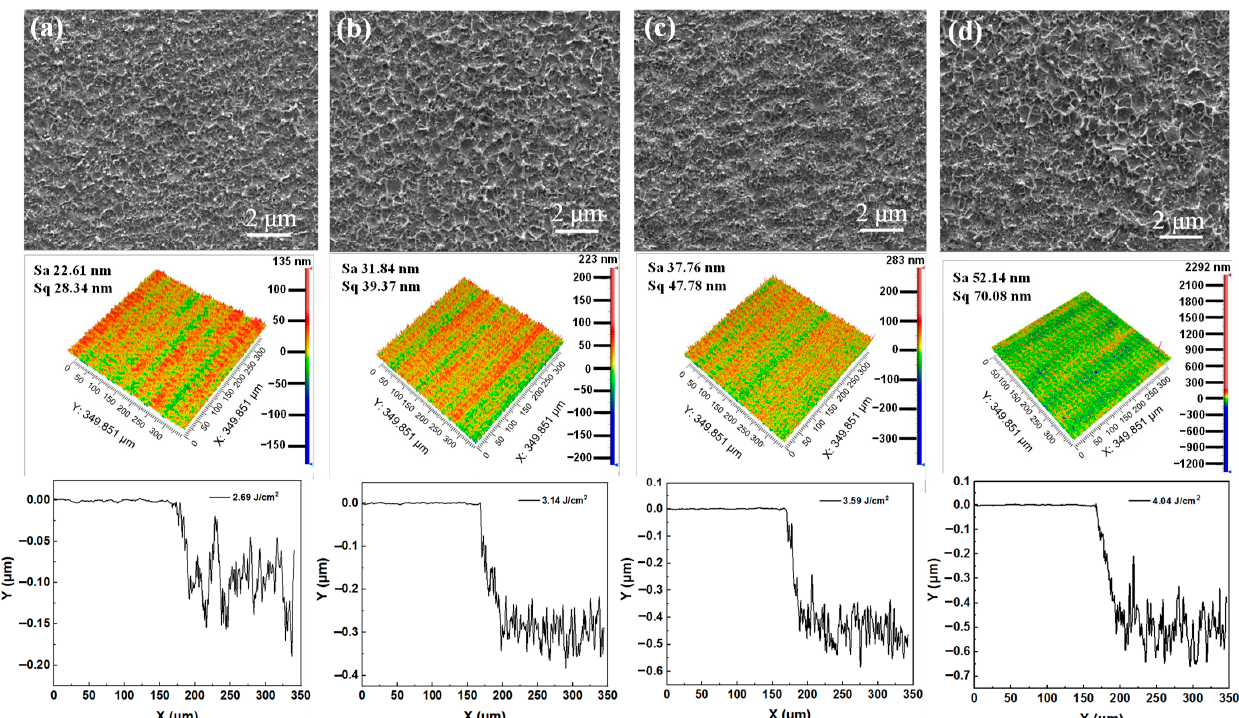
Figure 4. Surface morphologies and 3D morphologies of Cu films ablated by the 0° nitrogen plasma − assisted ps − lasers at different laser fluences: ( a ) 2.69 J/cm 2 , ( b ) 3.14 J/cm 2 , ( c ) 3.59 J/cm 2 and ( d ) 4.04 J/cm 2 .